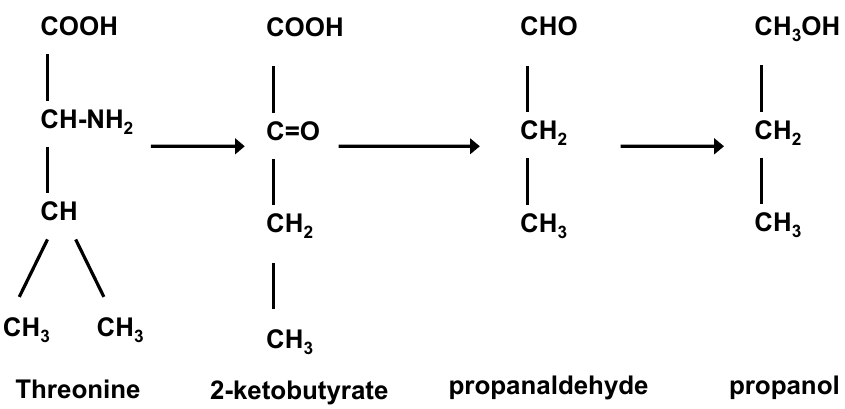
Figure 7. Anabolic route for the synthesis of fusel oils.